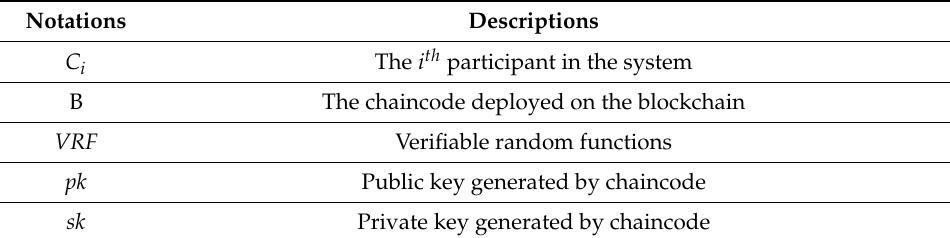
Table 1. Summary of